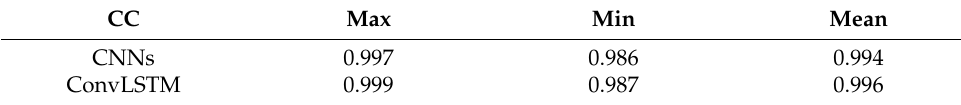
Figure 8. Comparison of the anomalies between different results, namely, monthly average ( a ), CNNs daily prediction ( b ), and ConvLSTM daily prediction ( c ) w.r.t the National Snow and Ice Data Centre (NSIDC) sea ice concentration (SIC) on 15 December 2018. The gray in the figure represents the land, and the blue/red represent the underestimation/overestimation of SIC. The area marked by the blue dotted line is the key contrast area in the following.